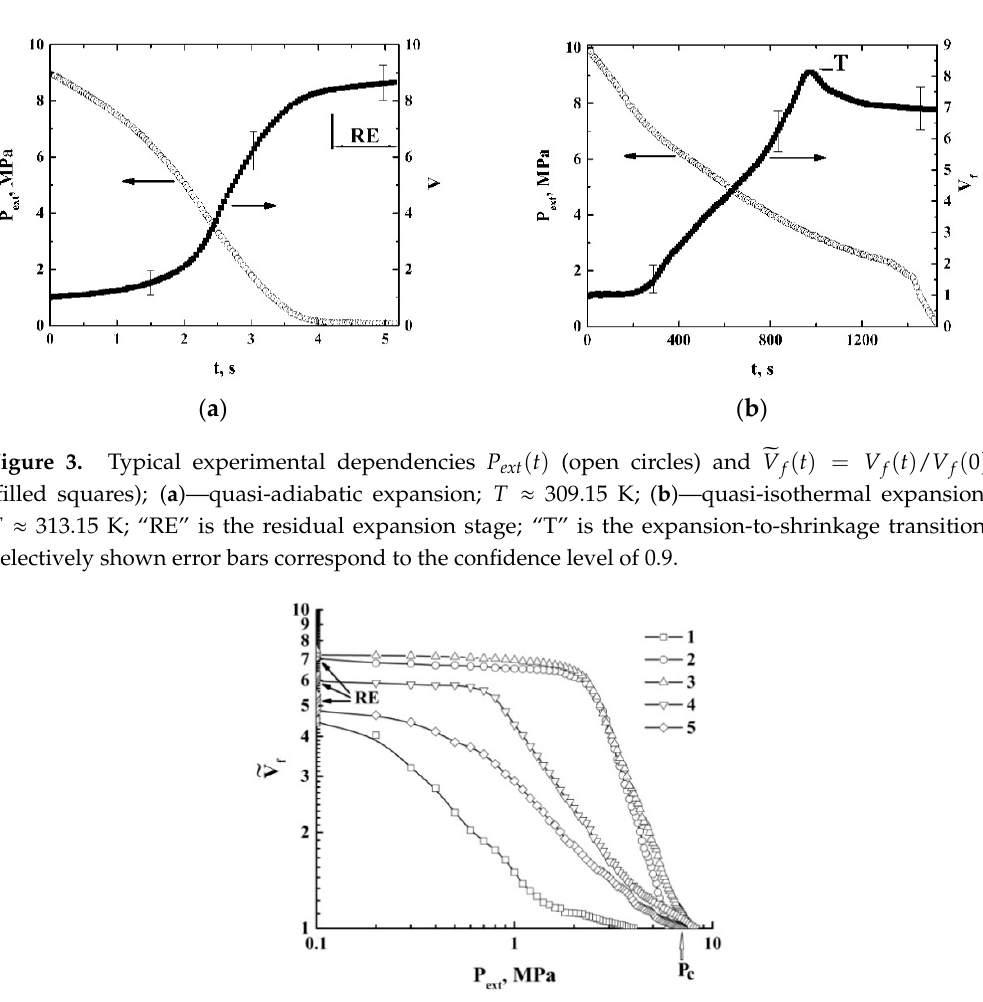
Figure 4. The family of quasi-adiabatic curves (cid:101) V f ( P ext ) for the polylactide foams. P ext ( 0 ) = : 1–4.0 MPa; 2–6.0 MPa; 3–8.0 MPa; 4–10.0 MPa; 5–11.0 MPa. “RE” marks the residual expansion.